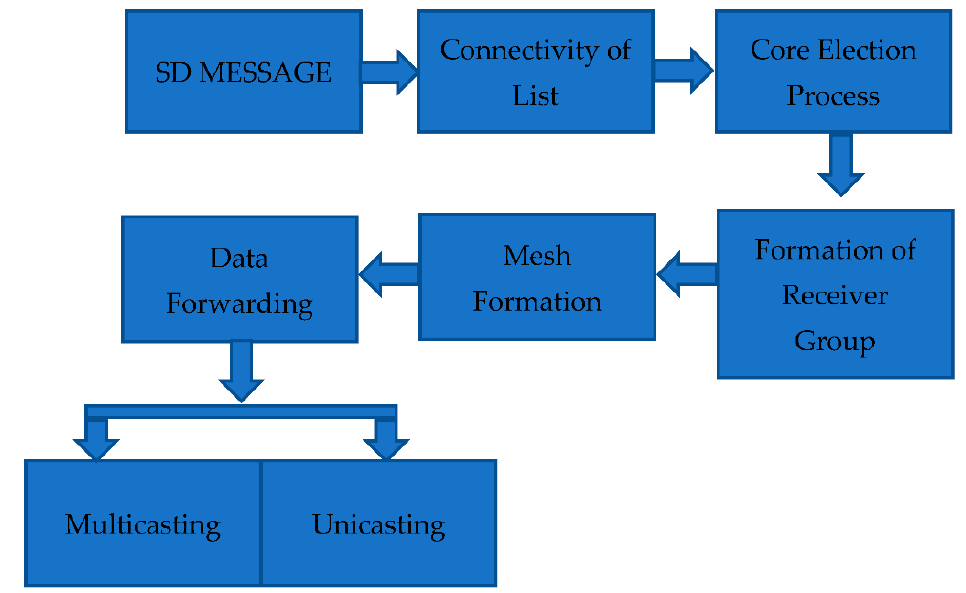
Figure 1. Block Diagram of the Proposed Protocol.